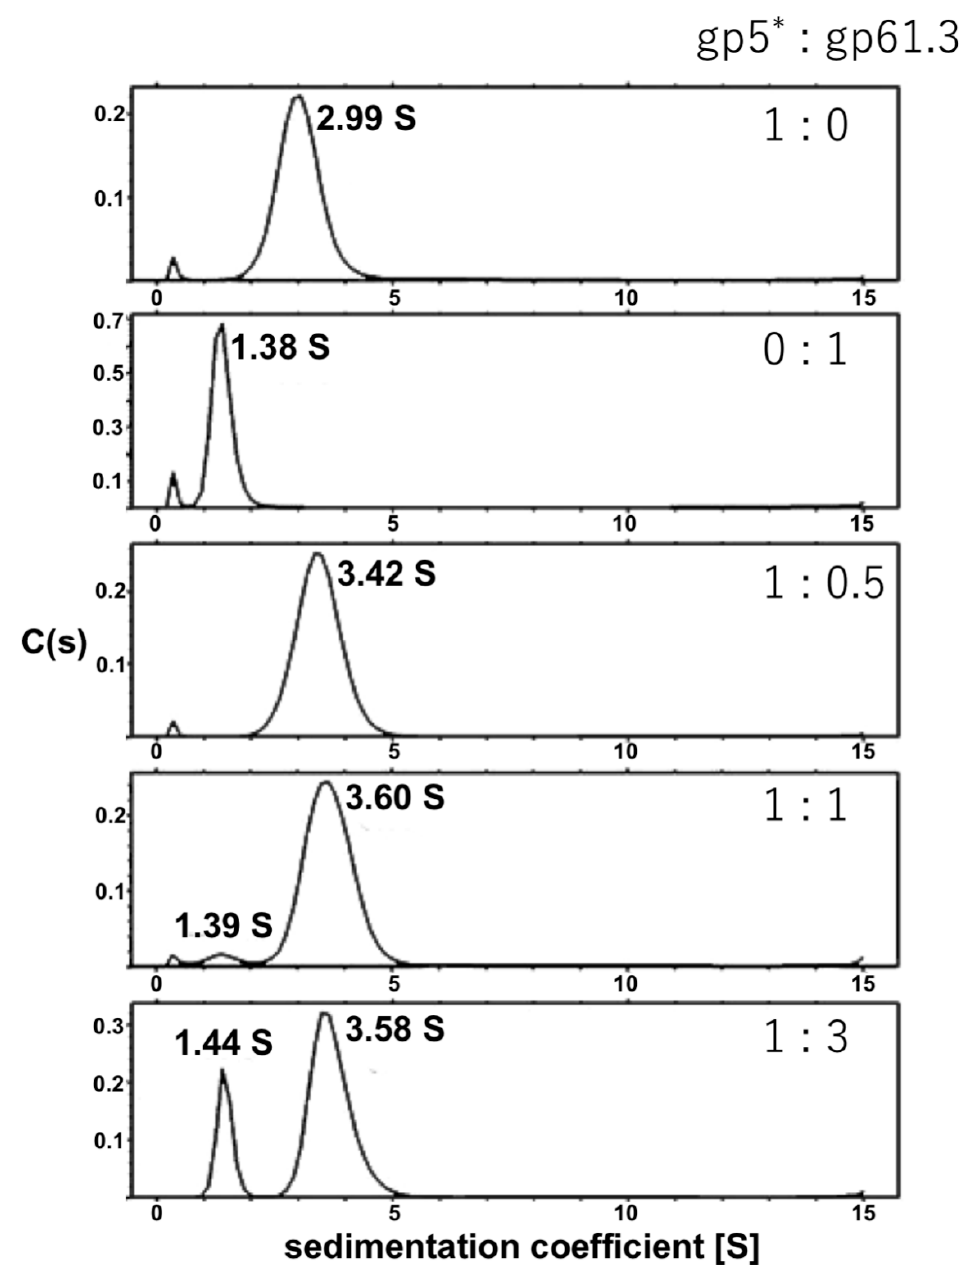
Figure 3. Sedimentation velocity analysis of gp5*:gp61.3 mixtures at different molar ratios (see M&M for detail).